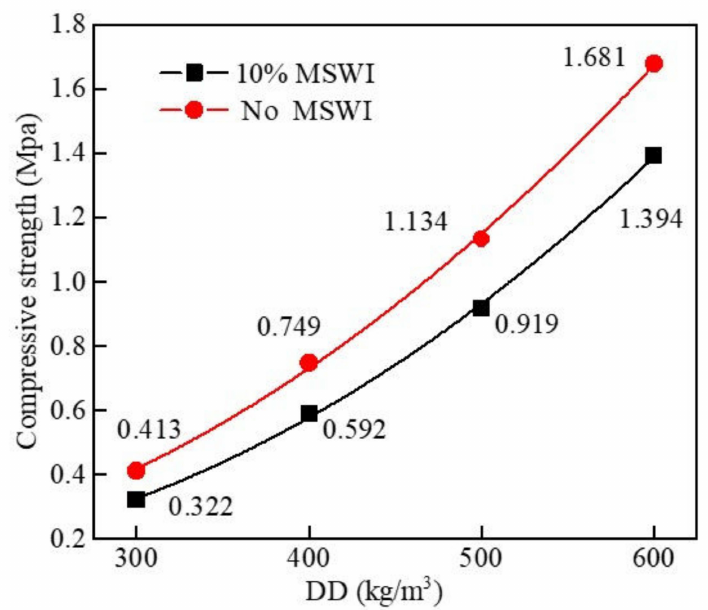
Figure 4. Compressive strength of foamed concrete with MSWI powder with different dry